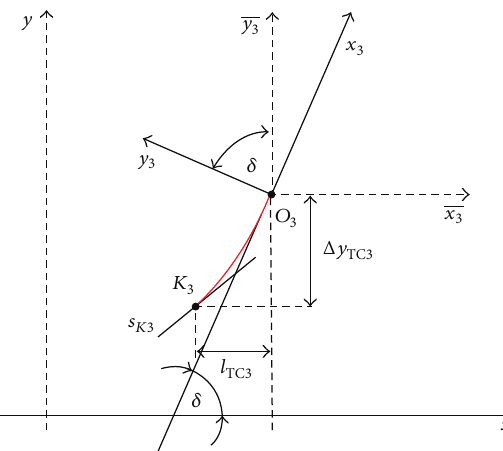
Figure 4: Diagram illustrating the position of transition curve